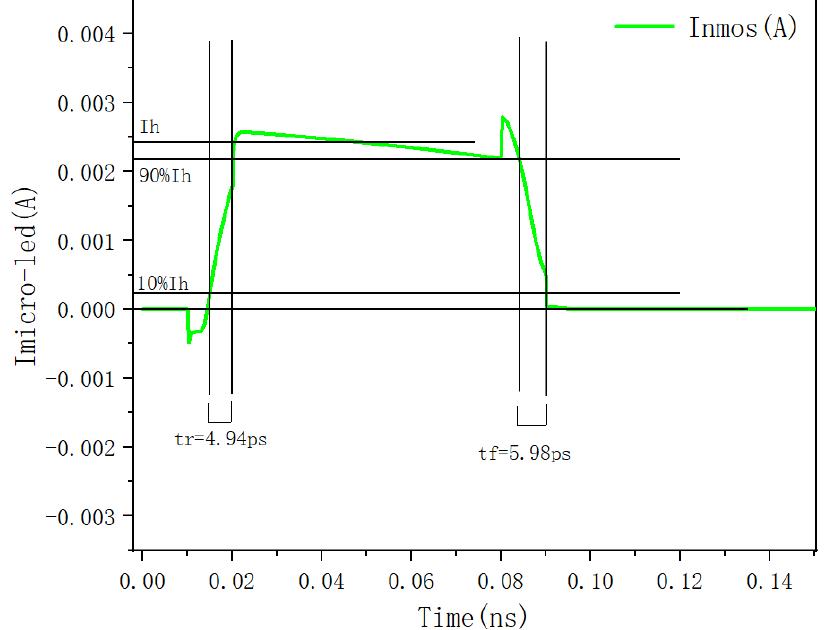
Figure 13. Analysis of the rising time and falling time of the output current curve of the NMOS directly driving the micro-LED with time.